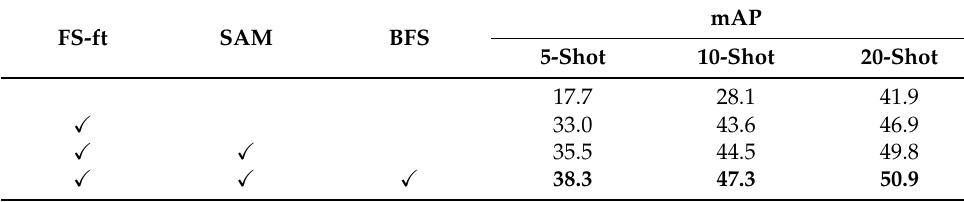
Table 4. Ablation study on the DIOR